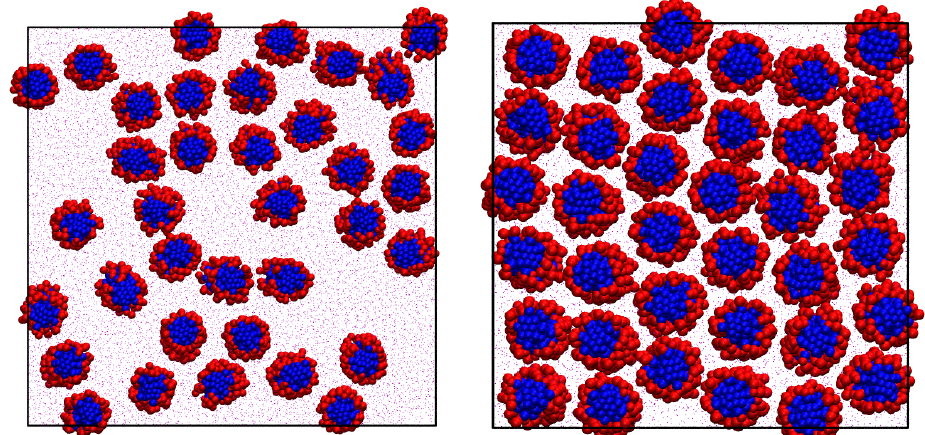
Figure 12. ( Top left ): the atomistic structure of PER and a coarse-grained representation suitable for use with bottom-up coarse-graining methods and the top-down Martini 3 approach. ( Top middle ): the potential of mean force for the binding of a PER dimer calculated from atomistic simulations, together with the lowest energy structure seen at the bottom of the potential well. ( Top right ): A snapshot from atomistic simulations showing the typical aggregate structure for PER. ( Middle left ): Aggregates of PER from a tuned Martini 3 model. ( Middle right ): A snapshot from the chromonic N phase of PER (water molecules not shown) obtained from long simulation runs using the tuned Martini 3 model developed in reference [8]. ( Bottom left ): Plan view of the N phase at 30 wt%. ( Bottom right ): Plan view of the M phase at 50 wt%. The top row sub-figures are redrawn